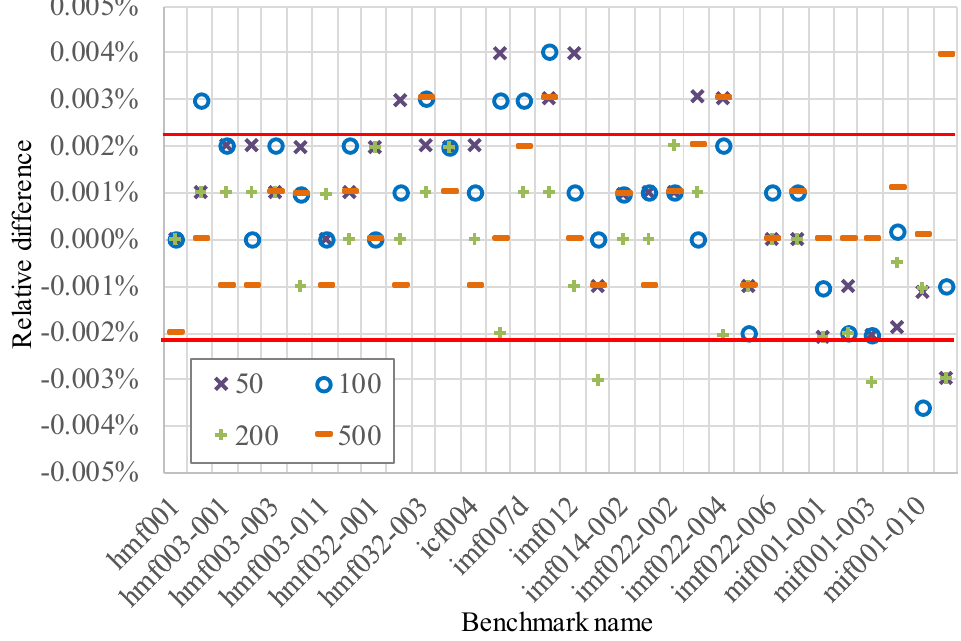
Figure 6. Comparison of k-eff values for ICSBEP benchmark in each ladder